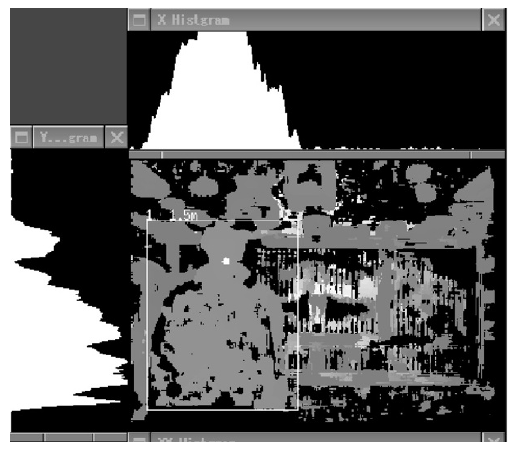
Figure 2: Example of the background subtraction for human track- ing.